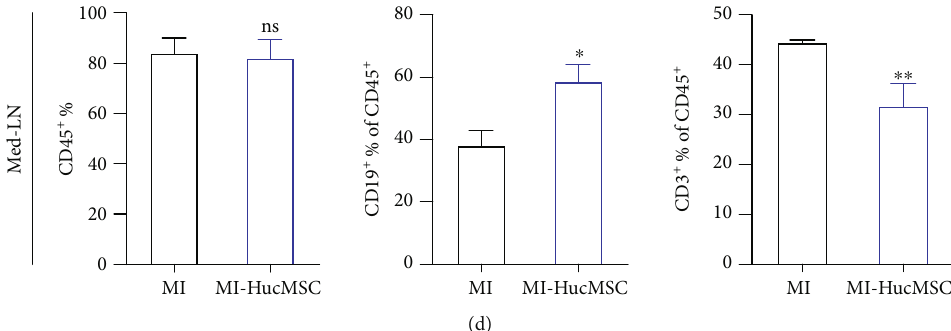
Figure 3: Systemic immunomodulatory e ff ects of iv-administered HucMSC at 7-day post-MI. (a) Gating strategy and representative images of fl ow cytometry in the peripheral blood at 7-day post-MI. (b) The ratio of immune cells (CD45 + %), B cells (CD19 + % of CD45 + ), and T cells (CD3 + % of CD45 + ) in the peripheral blood was analyzed by fl ow cytometry at 7-day post-MI. c) The ratio of immune cells (CD45 + %), B cells (CD19 + % of CD45 + ), and T cells (CD3 + % of CD45 + ) in spleen was analyzed by fl ow cytometry at 7-day post-MI. (d) The ratio of immune cells (CD45 + %), B cells (CD19 + % of CD45 + ), and T cells (CD3 + % of CD45 + ) in med-LNs was analyzed by fl ow cytometry at 7-day post-MI. n = 3 ~ 4 mice for each group. ns, non-signi fi cant vs. MI group; ∗ p < 0 : 05 vs. MI group; ∗∗ p < 0 : 01 vs. MI